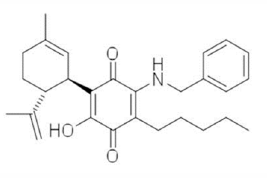
Figure 1. Chemical structure of VCE-004.8 (disclosed for the first time in [25]).